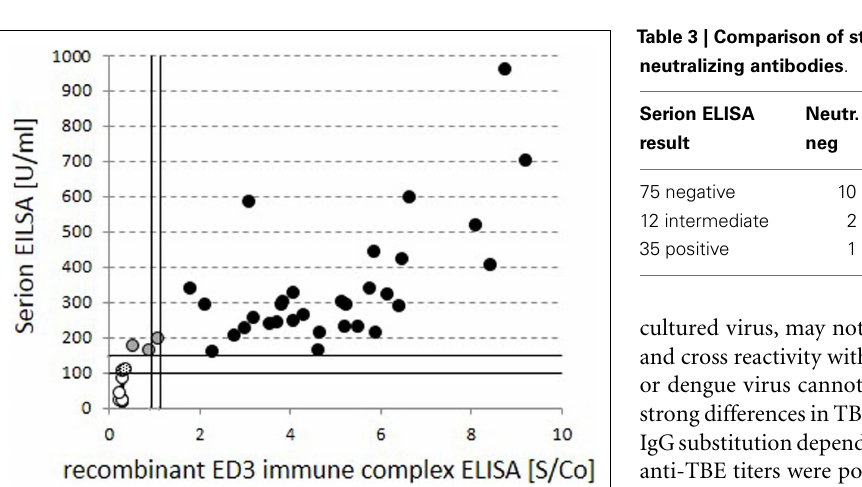
FIGURE 4 | Comparison of global vs. neutralizing anti-TBE IgG titers . Quantitative test results for global standard anti-TBE IgG titers from the standard ELISA are compared to neutralizing, anti-recombinant ED3 immune complex ELISA values within identical serum samples. Circles filled in black indicate positive and open circles indicate negative results in both tests. Gray and dotted fillings reflect deviant grading within the two assays.